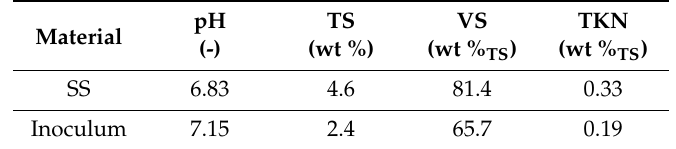
Table 1. Selected physicochemical parameters of the substrate and inoculum.